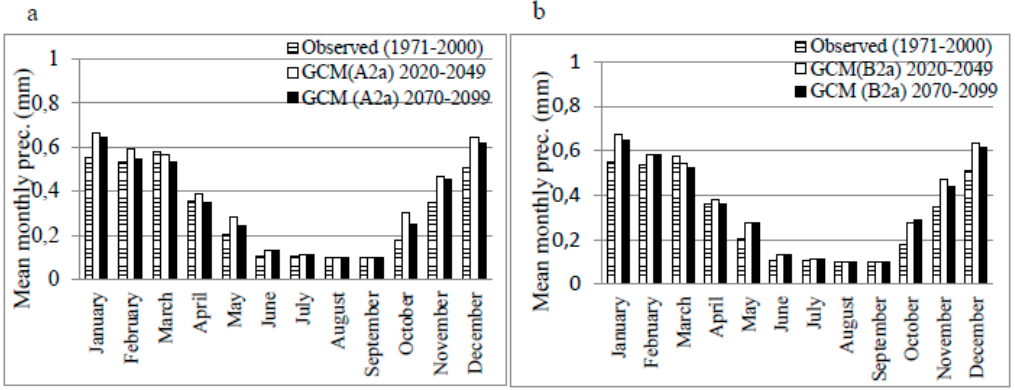
Figure 4. Values of the average monthly observed and predicted precipitation under ( a ) A2 and ( b ) B2 emission scenario in the near and far future.